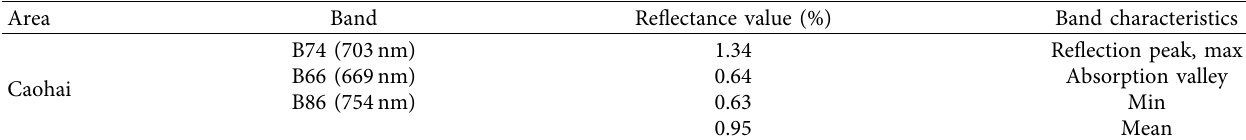
Figure 4: Spectral reflectance curves of Caohai and Waihai in the red band. Table 2: Characteristic bands of Caohai and Waihai in the red